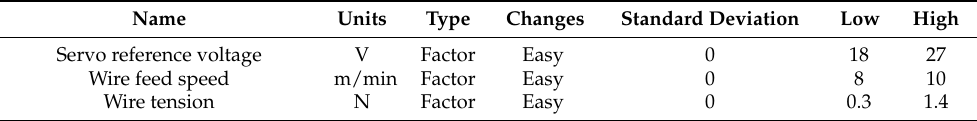
Table 3. Various process parameters range